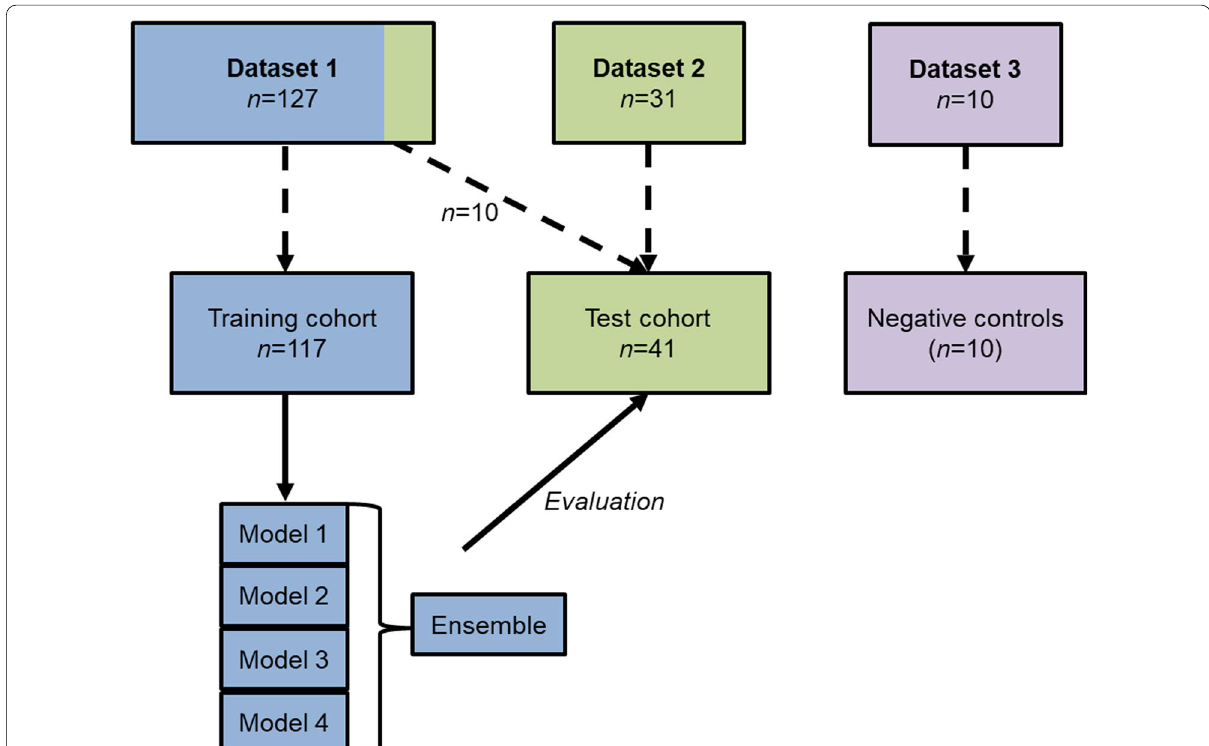
Fig. 2 Illustration of data used for training and test. The models and the ensemble hereof were inferred on the test cohort. Boxes are not drawn to scale